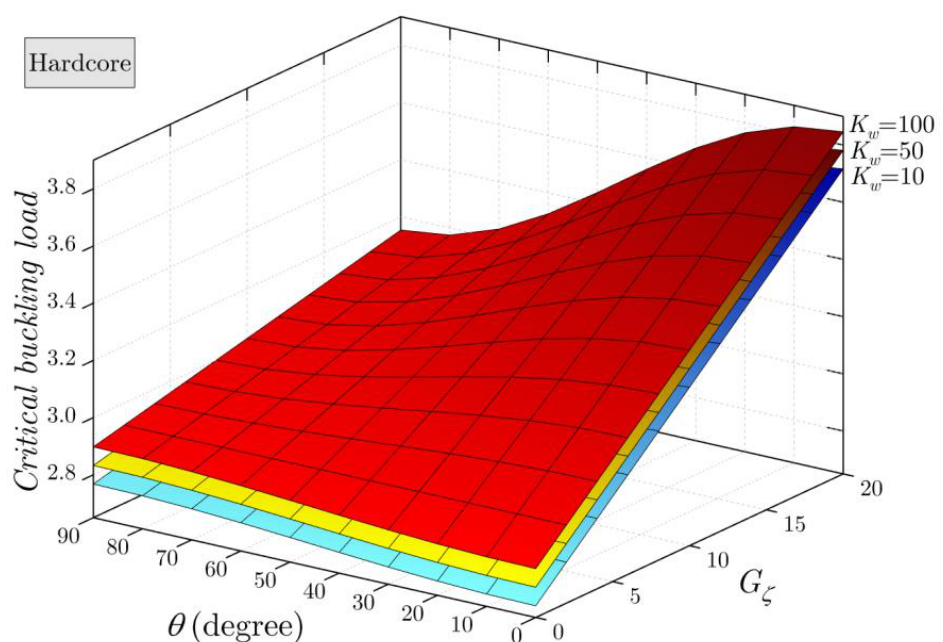
(cid:1) . = 𝐺 = 𝐾 = 0) . 𝜁 𝜂 𝑤